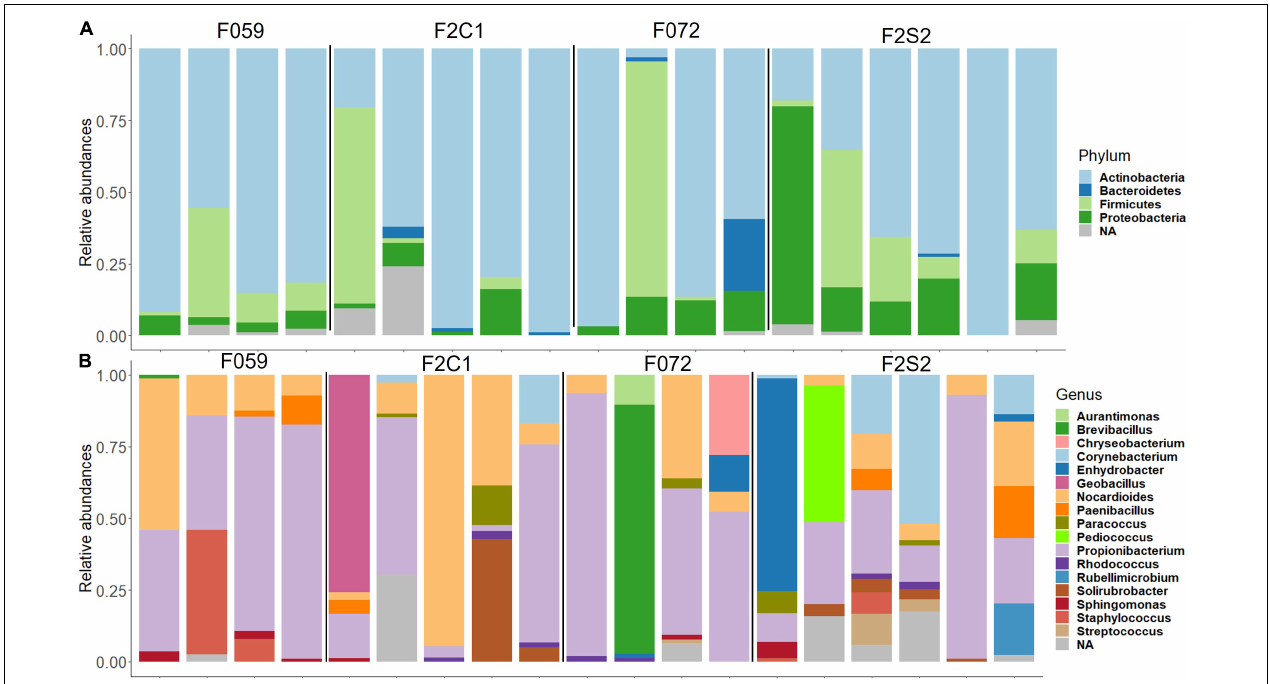
FIGURE 4 | Relative abundance of bacteria found in the mucus of the posterior intestine from Nile tilapia bred in captivity. (A) Phylum level. (B) Genus level. F0 generation: F059, F072 and F2 generation: F2C1 (Inbred), F2S2 (Inbred). NA,